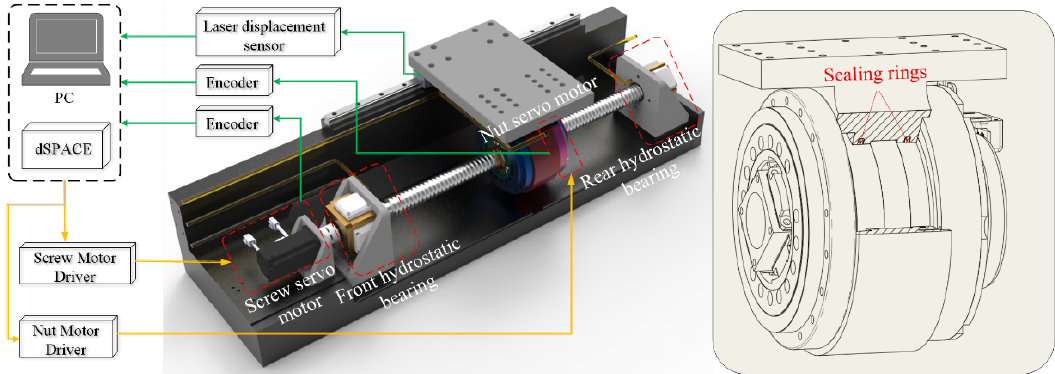
Figure 1. Block diagram of the DDHLS.